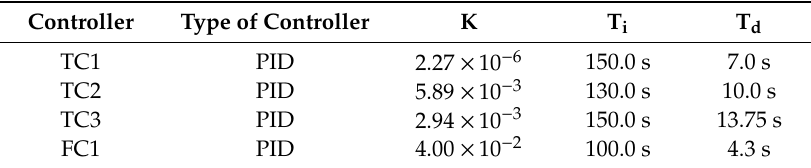
Figure 3. ( a ) Temperature profile of the reformer during TC1 controller tuning with Z-N method and ( b ) temperature profile of the reformer under three types of TC1 tuned controllers (P, PI, and PID). Table 3. Selection of controllers based on the tuning